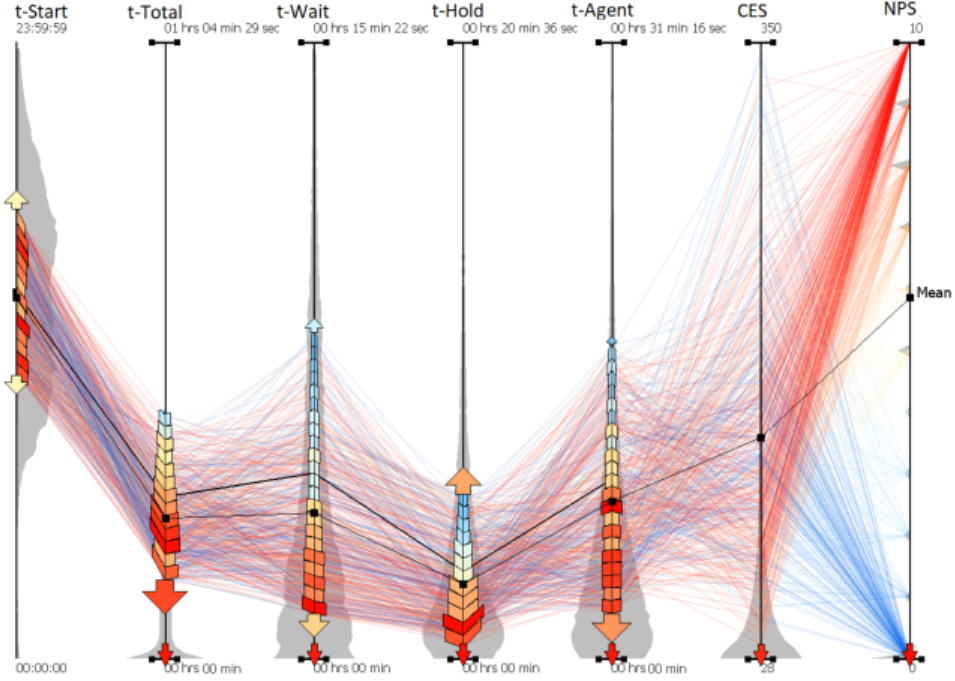
Figure 7. The sketch brush placement with the dynamic brush interval range glyphs which were automatically placed at 1 standard deviation from the mean. Image courtesy of Roberts et al.